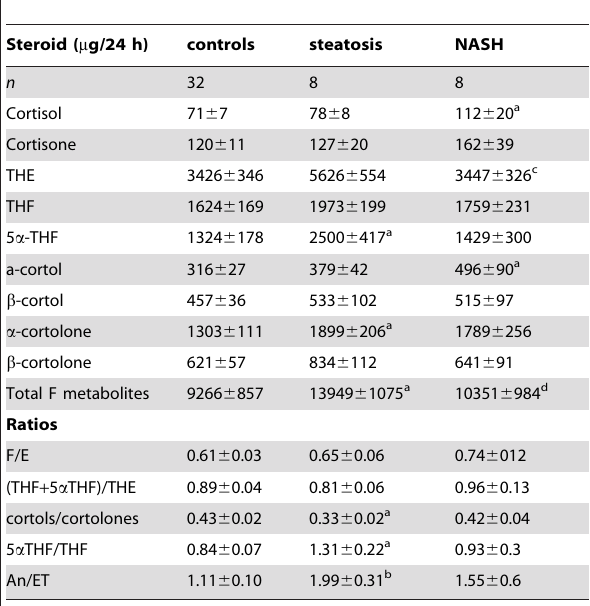
Table 2. Urinary steroid metabolites and ratios in patients with steatosis, NASH and control